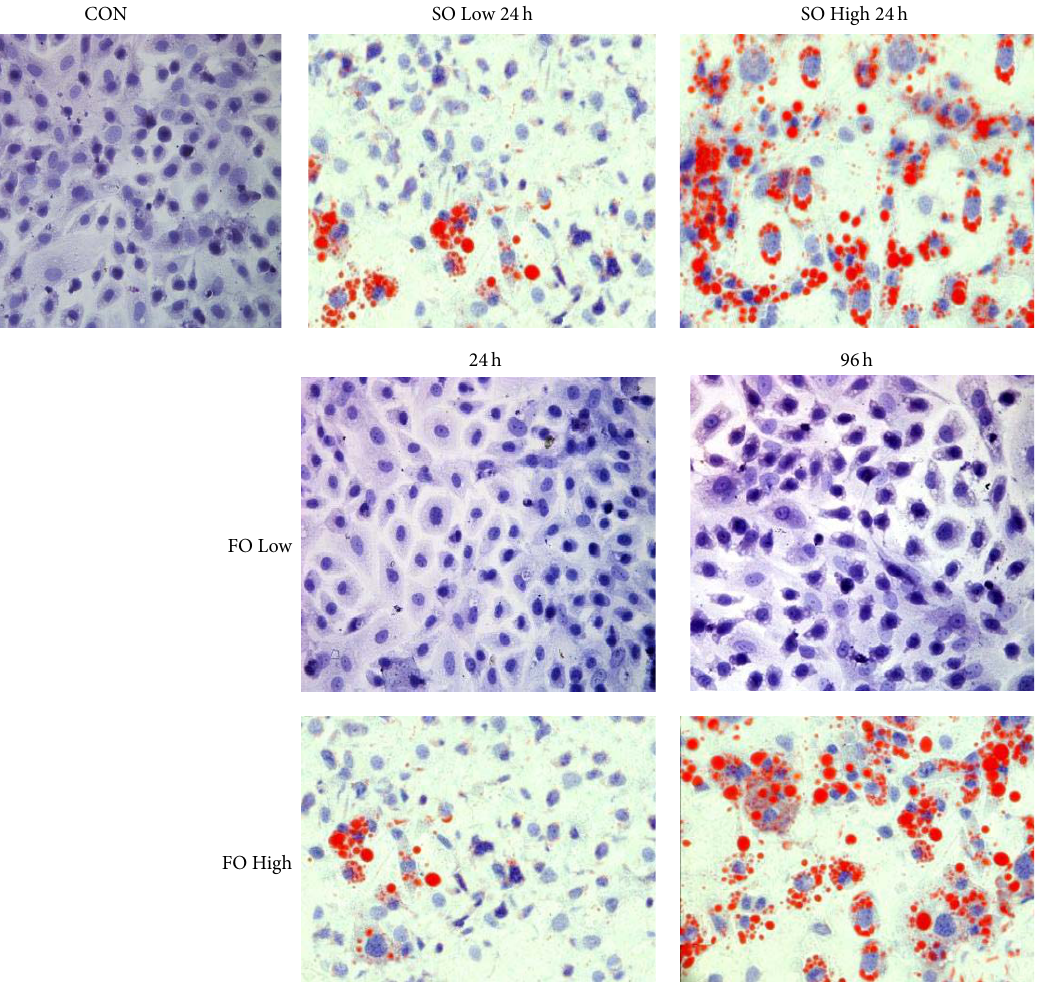
Figure 2: Soybean oils cause greater hepatocyte injury and LD accumulation than fish oil. Primary hepatocytes were treated with 0.4% or 1% soybean or fish oil-based lipid emulsions and cellular LD accumulation was detected using oil red O staining. LD, lipid